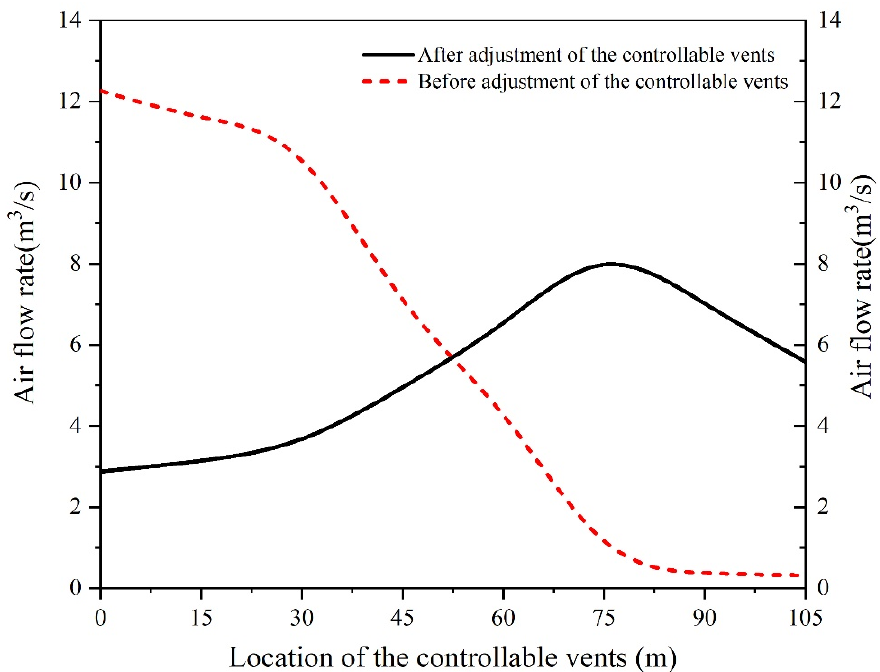
Figure 9. Comparison of the airflow rate distribution before and after adjustment of the controllable vents.